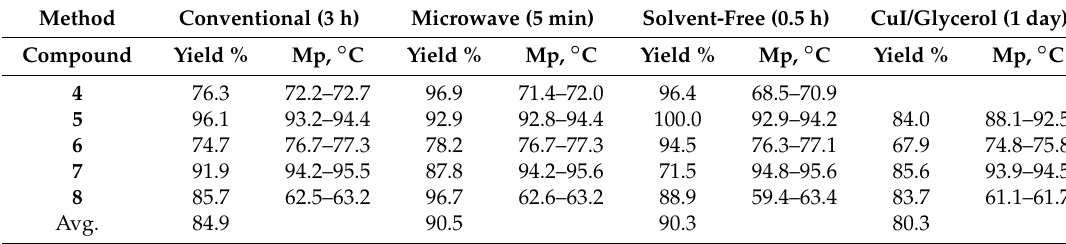
Table 3. Fluorinated triazoles yield and melting range 1